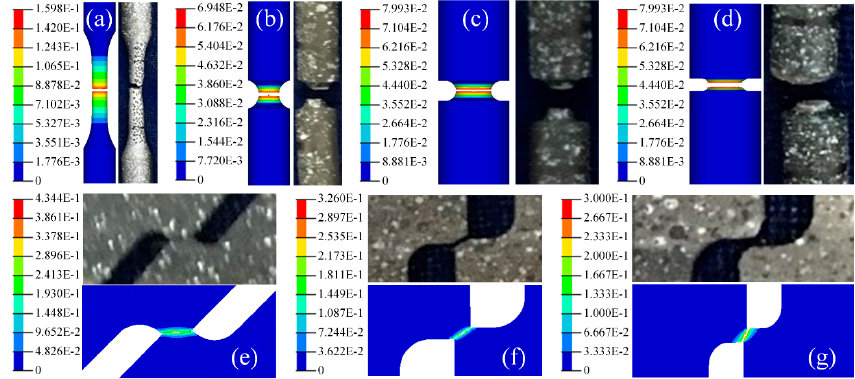
Figure 9. Fracture mode for 20CrMnTiH steel for ( a ) smooth tensile test, ( b ) notched test for notched radii 2 mm, ( c ) notched test for notched radii 0.8 mm, ( d ) notched test for notched radii 0.4 mm, ( e ) pure shear test, ( f ) shear and tensile test at shear angle 30° and ( g ) shear and tensile test at shear angle 60°.